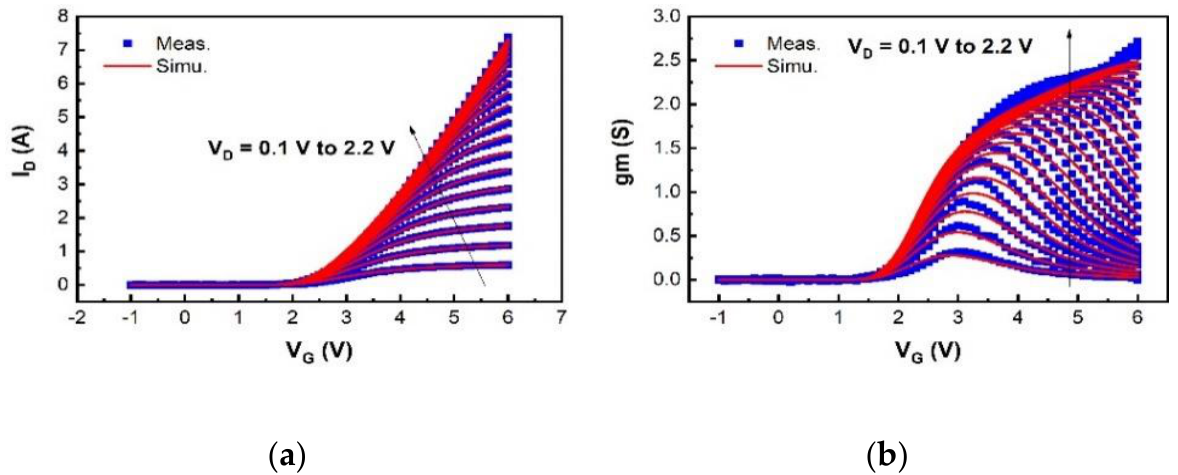
Figure 2. The equivalent circuit of the capacitance of field plates (FPs) of a p-GaN gate HEMT.